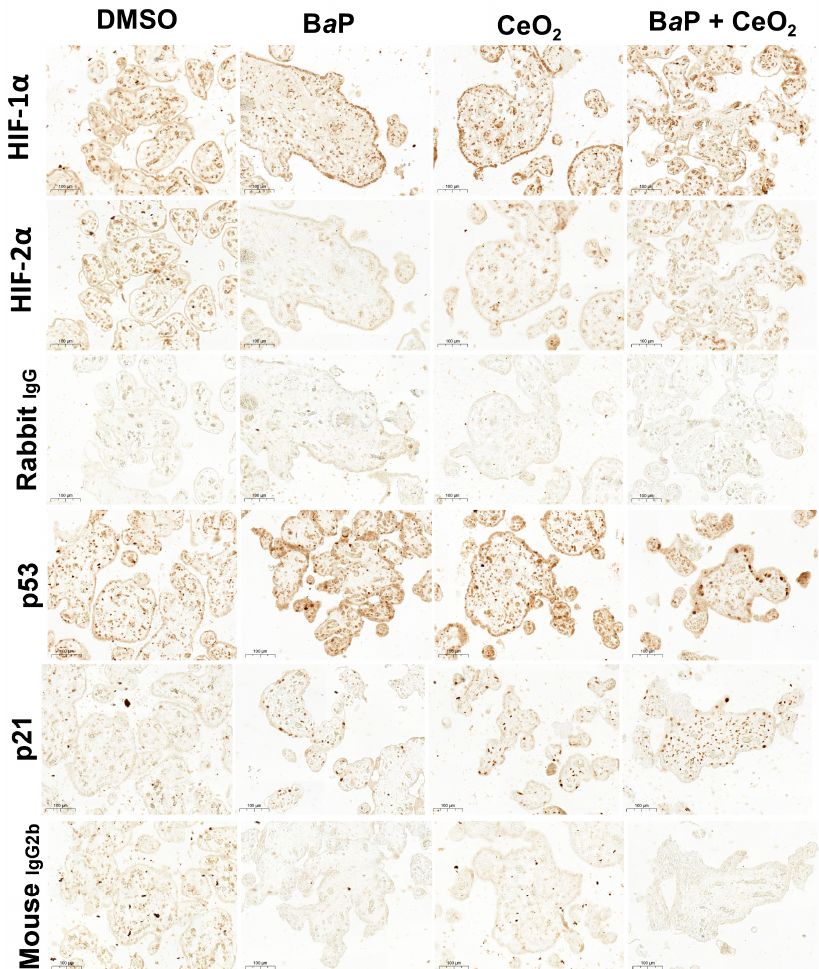
Figure 8. Immunohistochemistry of HIF, p53, and p21 after chorionic villi exposure to benzo(a)pyrene or/and cerium dioxide nanoparticles. Representative images of immunohistochemical staining of HIF-1 α , HIF-2 α , p53, p21, and negative controls (rabbit IgG and mouse IgG2b) from placental explants incubated with DMSO, B a P (1 µ M), and/or CeO 2 NP (10 µ g/cm 2 ) for 24 h ( n = 3). Quantitative analysis of HIF-1 α , HIF-2 α , p53, and p21 expression was performed using the ImageJ plugin. Values represent means ± SEM. * p < 0.05, ** p < 0.01, *** p < 0.001, **** p < 0.0001 vs.